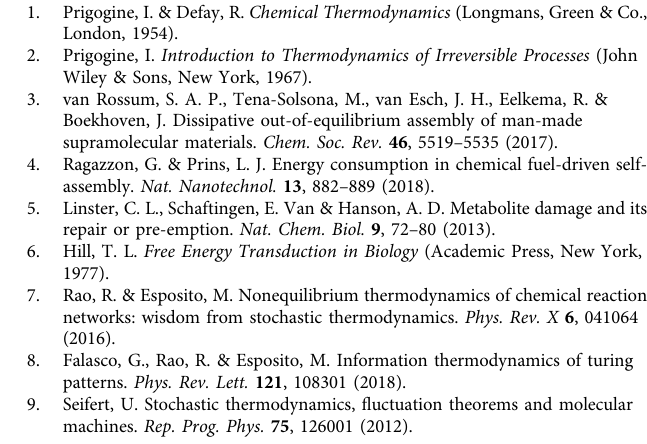
Fig. 4 Performance of driven synthesis. a Ef fi ciency ( η ds ) of driven synthesis as function of F driven synthesis are colored in gray. The yellow dashed (resp. orange solid) line denotes the maximum of η ds (resp. (cid:2) _ W versus k ext , while the black solid line corresponds to η ds = 0. b , c (resp. d , e ) Concentrations and currents as a function of k ext (resp. F F ¼ 7 : 5 (cid:7) RT (resp. k = 1 s − 1 ) highlighted by blue vertical (resp. horizontal) dotted line in plot ( a ). Kinetic constants and standard chemical potentials ext fuel are the same as for ES analysis (see Supplementary Information). Note that J 3 = I ext + J 4 always holds, where J 3 = J 3F + J 3W is the net current fl owing